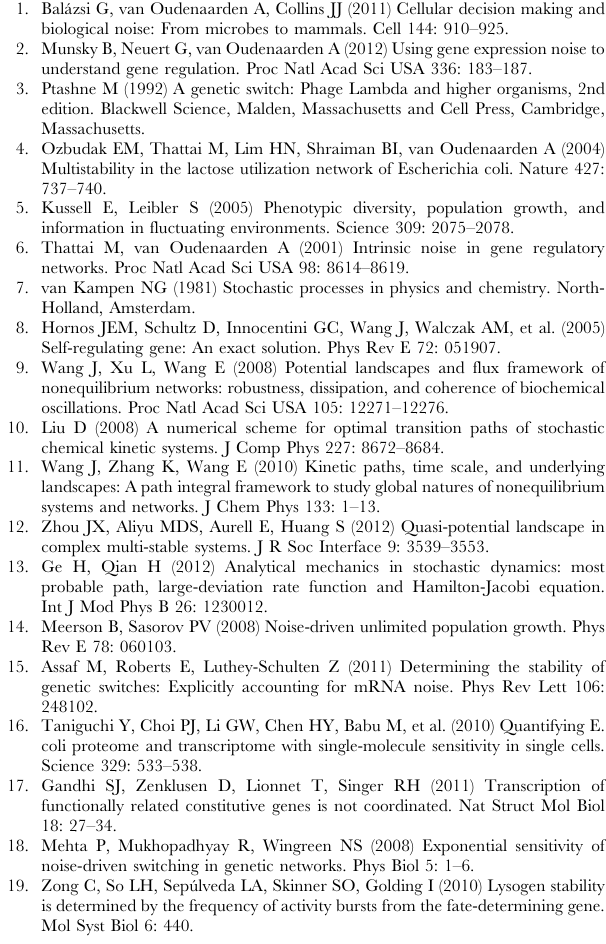
Figure S2 Coefficient of variation as a function of